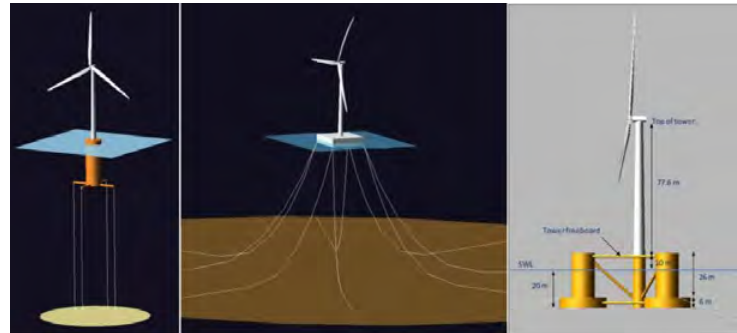
Figure 3. NREL 5 MW wind turbine on (left to right) theMIT/NREL TLP, ITI Energy Barge (MATLAB and Statistics